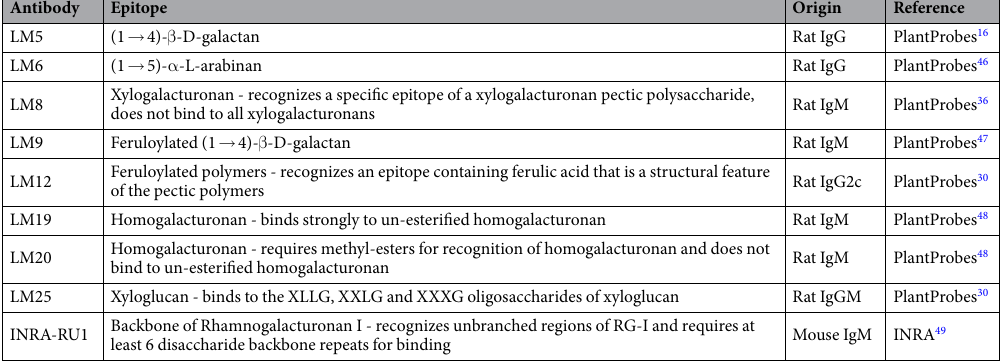
Table 4. Monoclonal antibodies tested against cassava cell wall, their corresponding epitopes and source